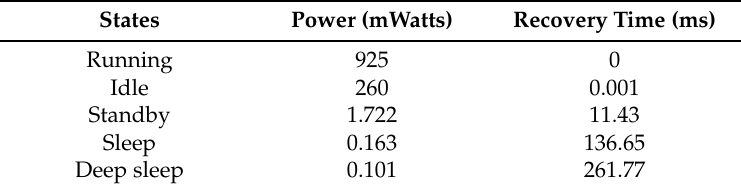
Table 2. Power states of the PXA270 processor [30].